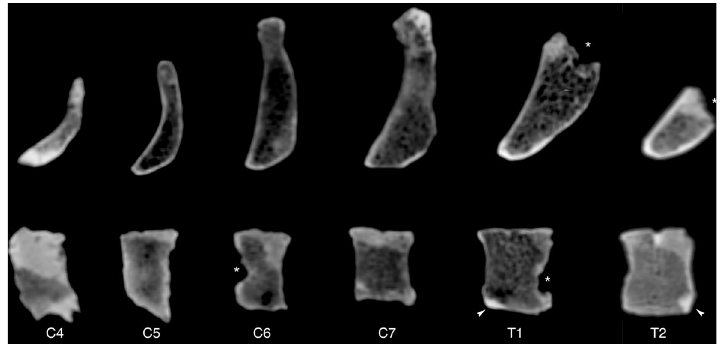
Figure 7. Midsagittal CT sections of vertebrae C4 to T1. Note the patchy mineralisation of the fossil vertebrae. Probable taphonomic defects are marked by asterisks. The anterosuperior and the anteroinferior rims of vertebral bodies T1 and T2, respectively, have been reconstructed in plasticine (arrowheads).